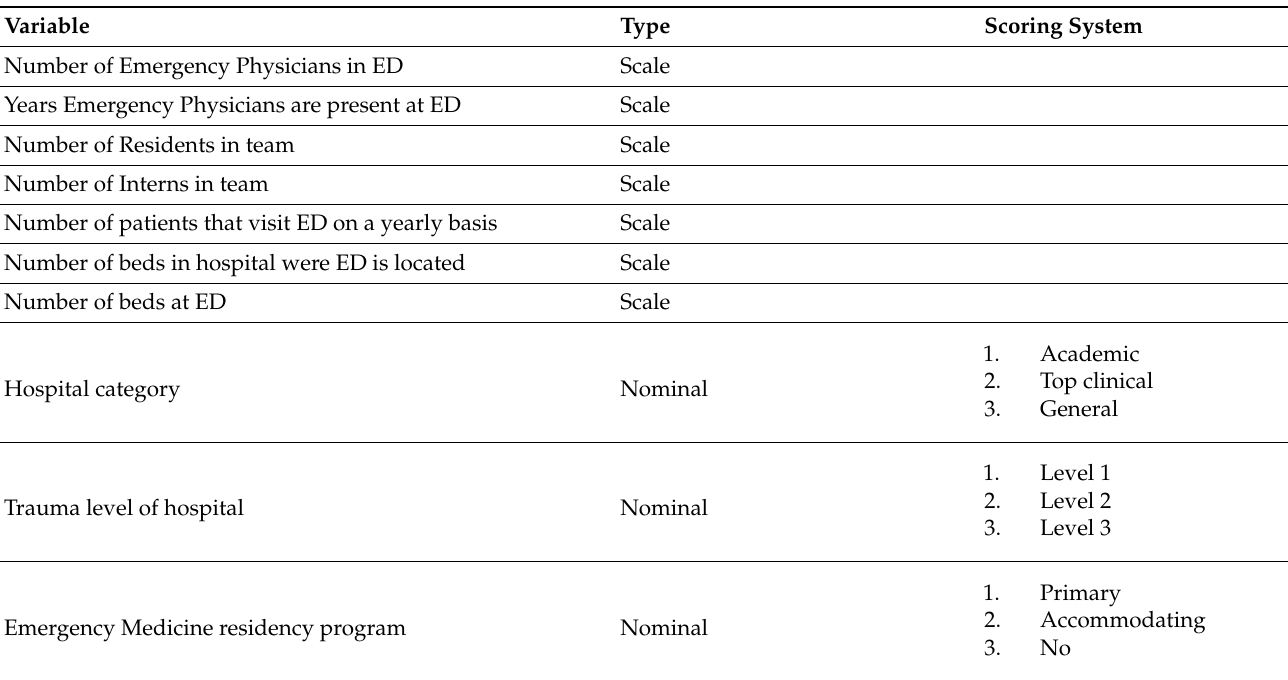
Table A2. Content questionnaire characteristics